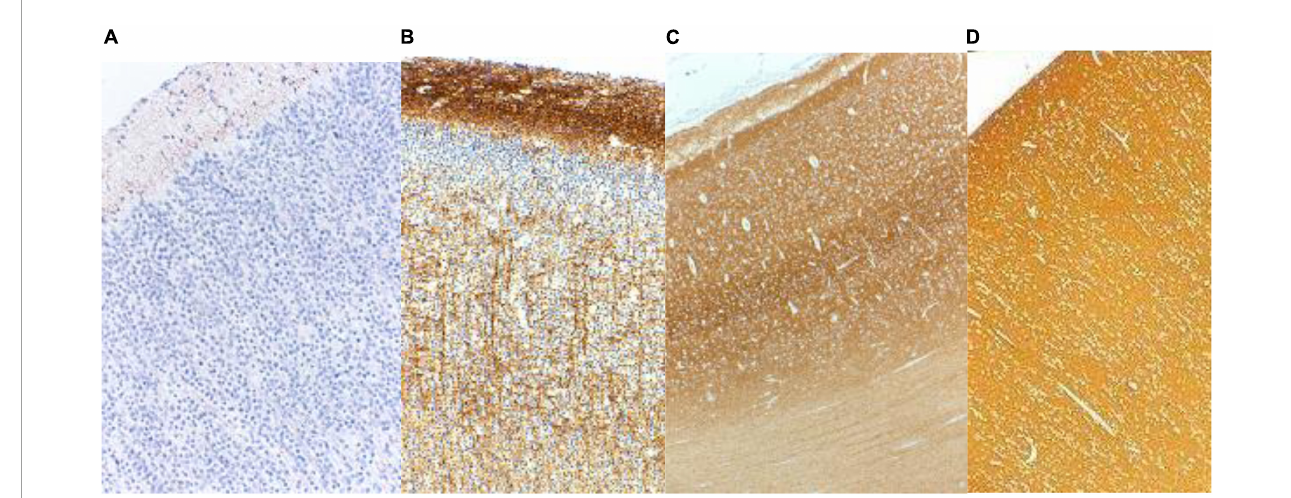
FIGURE2 Synaptophysin reactivity in the human cerebral cortex at (A) 20 weeks; (B) 26 weeks; (C) 33 weeks; and (D) 40 weeks gestational age. At mid-gestation (20 weeks) only minimal reactivity is seen in transverse axons of Cajal-Retzius neurons of the molecular zone. At 26 weeks the molecular zone and deep cortical layers are reactive, superficial layer 2 is still non-reactive, and coarse radial thalamo-cortical axons also are evident. At 33 weeks the deeper layers of cortex are more intensely reactive than are the superficial layers. At term the cortex is uniformly reactive throughout. Reproduced from reference (Sarnat et al.,